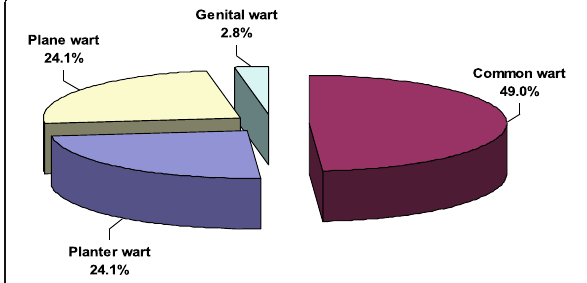
Fig. 1 Type of warts among primary school students, Tema District, Sohag, Egypt